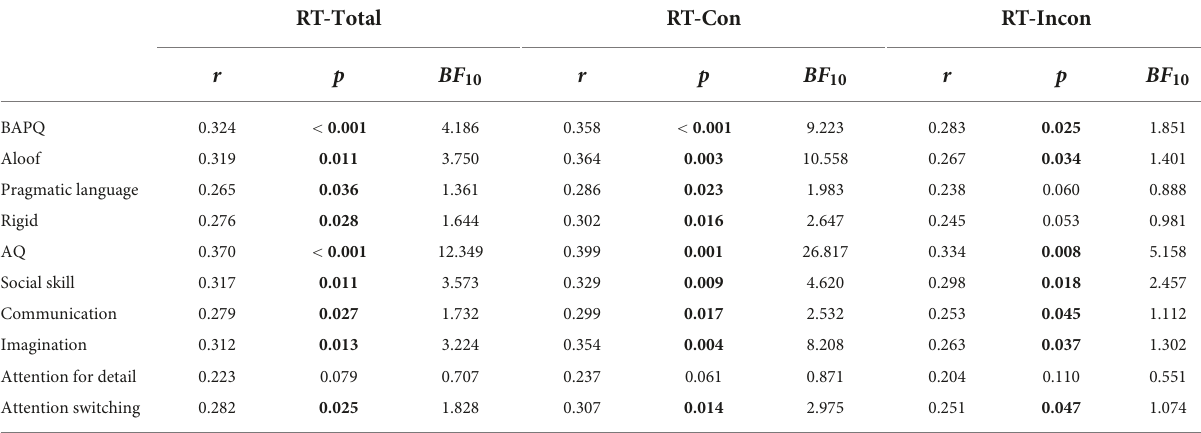
TABLE 6 Correlation analysis between reaction time and score on broad autism phenotype questionnaire (BAPQ) and autism-spectrum quotient